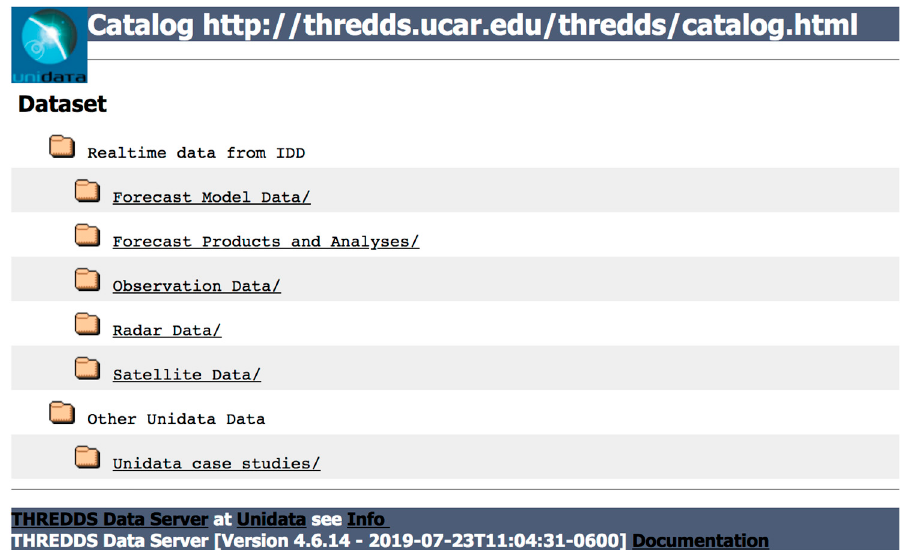
Figure 2. Top level Unidata THREDDS Data Server (TDS) catalog listing.